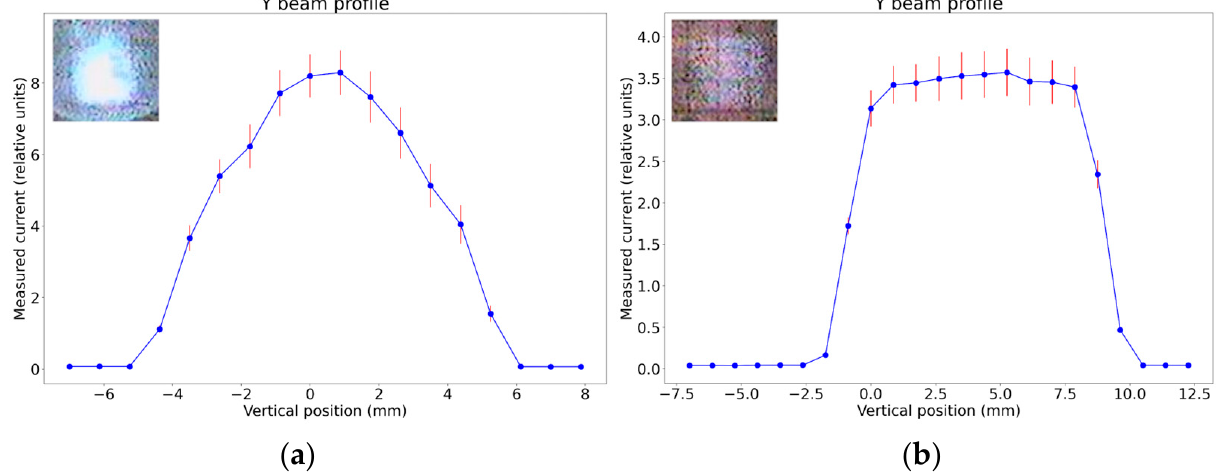
Figure 11. Results of BPM measurements for 10 MeV Fe +4 beam. Ion flux vertical profile: ( a ) for stationary ion beam, with the maximal opening of slits; ( b ) for scanning ion beam, with irradiation area width set by slits on 10 mm width. Insets are the luminescence image of each beam as seen on the quartz.